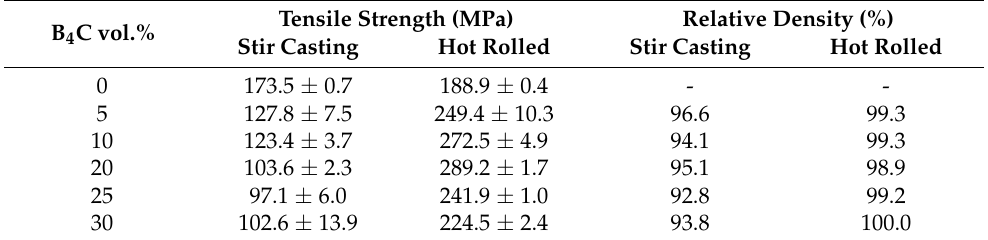
Table 2. Summarized tensile strengths and relative densities of Al6061 and B 4 C/Al6061